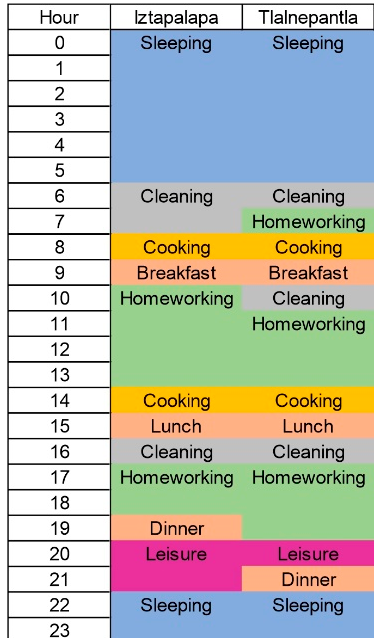
Figure 2. Typical activities schedule of the occupants of both households.